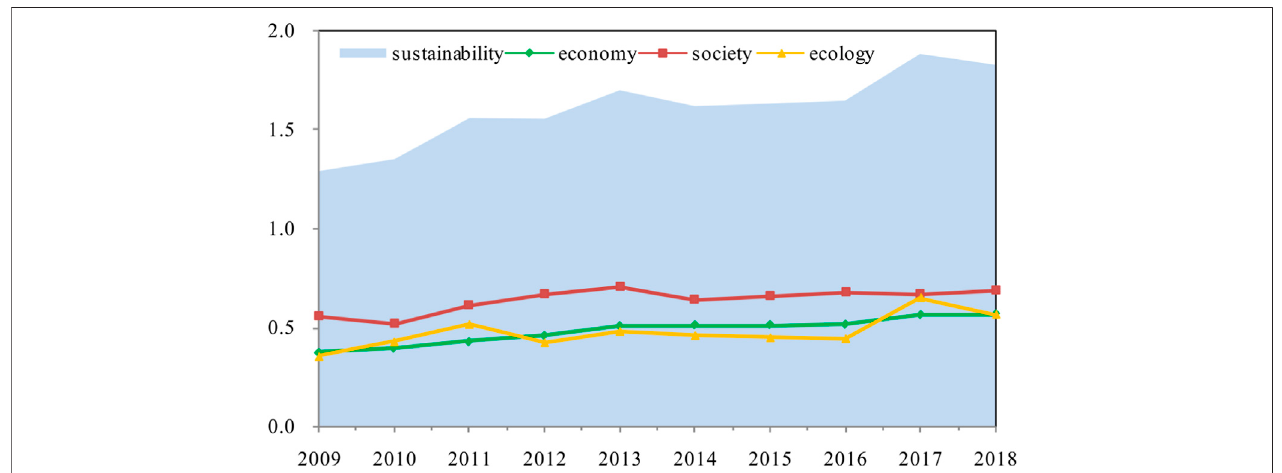
FIGURE 2 | The comprehensive evaluation value for river basin sustainable development.